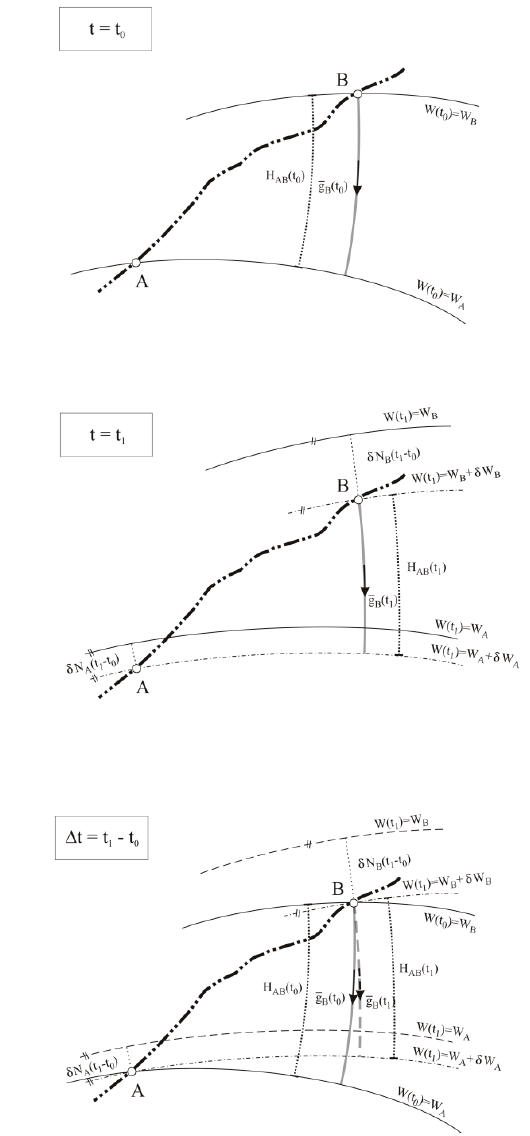
Figure 2. The ground, potential surfaces, plumb lines and height dif- ferences before the construction (top), after the construc- tion (middle) and comparison of the two